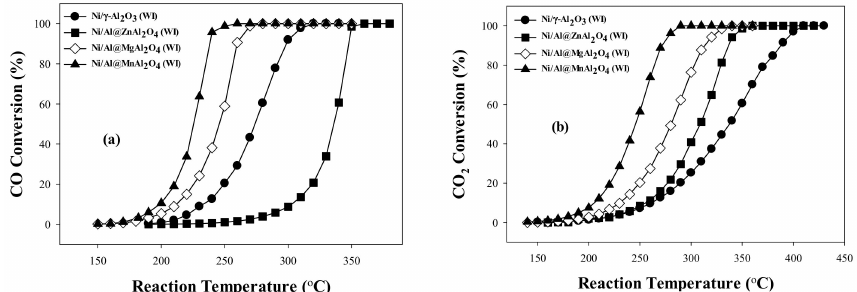
Figure 5. Catalytic performance of supported Ni catalysts prepared using the WI method for ( a ) CO methanation and ( b ) CO 2 methanation. All catalysts were reduced in H 2 at 500 ◦ C. Reaction conditions: 1 mol.% CO (or CO 2 ), 50 mol.% H 2 , 49 mol.% He, F / W = 1000 mL / min / g cat . The catalytic activity of